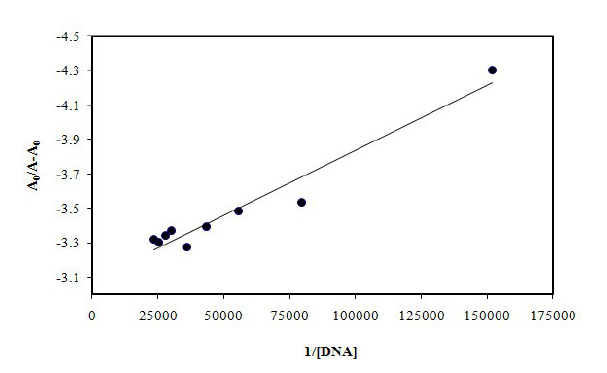
Figure 3. Plot of A /(A － A ) versus 1/[DNA] for EPR-DNA system at 360nm in 293 K (A) 0 0 and 313 K (B). Conditions: phosphate buffer (0.1 mol L -1 , pH 7.4), C